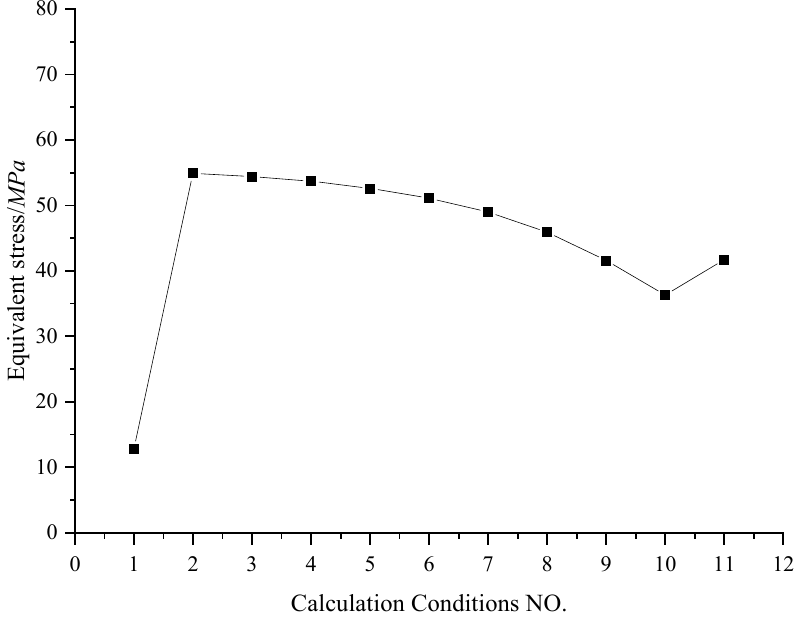
Figure 17. Radial deformation Ux of CR under local coordinate system at each step.